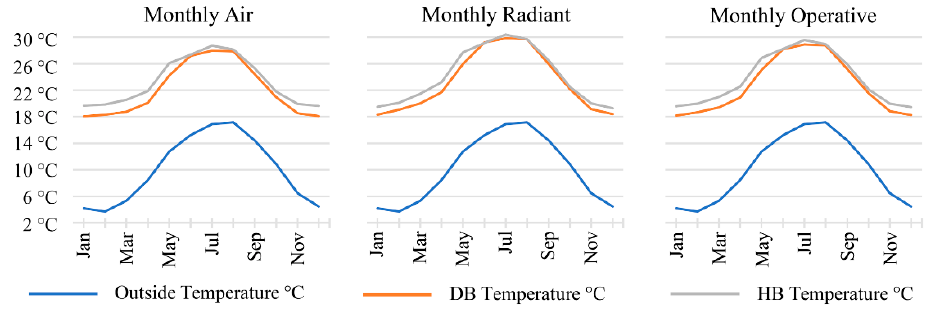
Figure 9. Monthly temperature comparisons between DB and HB.